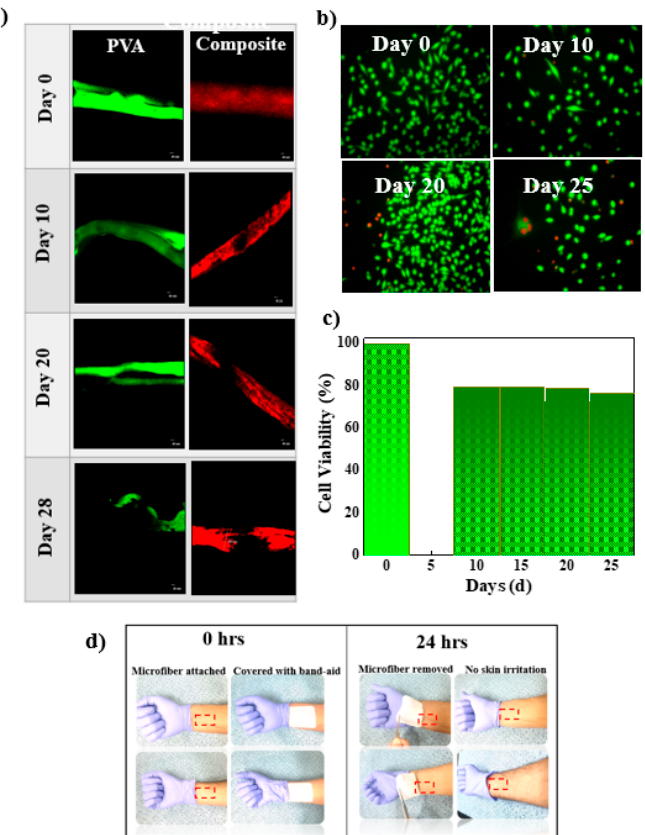
Figure 3. Biodegradability of the microfiber. The PVA microfiber and biodegradable PGS:PVA composite microfiber with a loading ratio of 2:1.5 were modified by incorporating FITC and Fluoresbrite ® dye, respectively, and the images were captured using a confocal microscope. ( a ) Biodegradability pattern of PVA (green) and PGS:PVA (red) microfibers from 0 to 28 days. The composite microfiber shows the fast degradation while stiff PVA shows slow degradation. After 28 days most of the the PVA and composite microfibers are degraded at set conditions. ( b ) Cell viability was assayed by LIVE/DEAD cell staining in the solution (live cells as green fluorescence and dead cells as red fluorescence) at an interval of 5 days. The scale bar is 20 µm. ( c ) Cell viability data evaluated by LIVE/DEAD cell staining. ( d ) Photographs of a 1cm long microfiber attached to skin with a cotton band-aid (left panel). After 24 h, the sample was removed (right panel) from the skin, and no redness or irritation was observed. After removing the microfiber there was no allergic reaction and no itching was reported by any of the four volunteers.